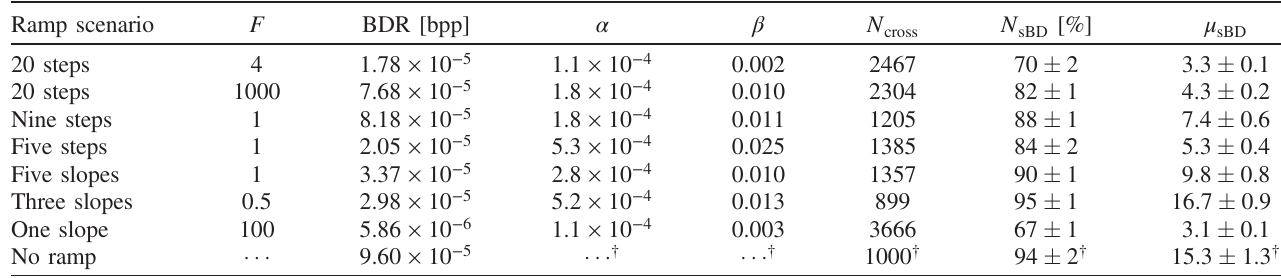
TABLE I. Numerical comparison of the eight different voltage ramping scenarios, each described by the number of steps or slopes. Each was measured during a flat mode run with a repetition rate of 2 kHz, after a relaxation by conditioning. The F parameter specifies the shape of the ramping curve, BDR is breakdowns per pulse, α and β are fitting parameters of the two-exponential model, N is the cross number of pulses at which those exponentials intersect, N is the fraction of all BDs that occur below N , and μ is the mean sBD cross sBD number of consecutive BDs below N . The uncertainties are calculated as the standard error of the mean. For the scenario with no cross ramping, the two-exponential fit was impossible, meaning that the values denoted with † are not fully comparable to the others. Ramp scenario F BDR [bpp] α β